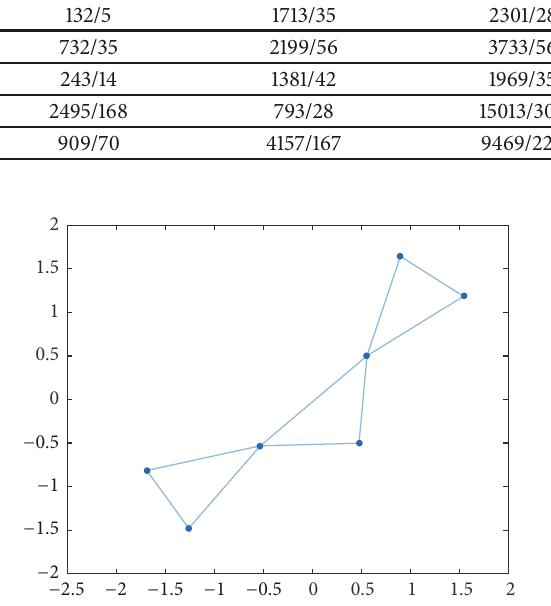
Figure 4: Regular triangular oxide network (unit